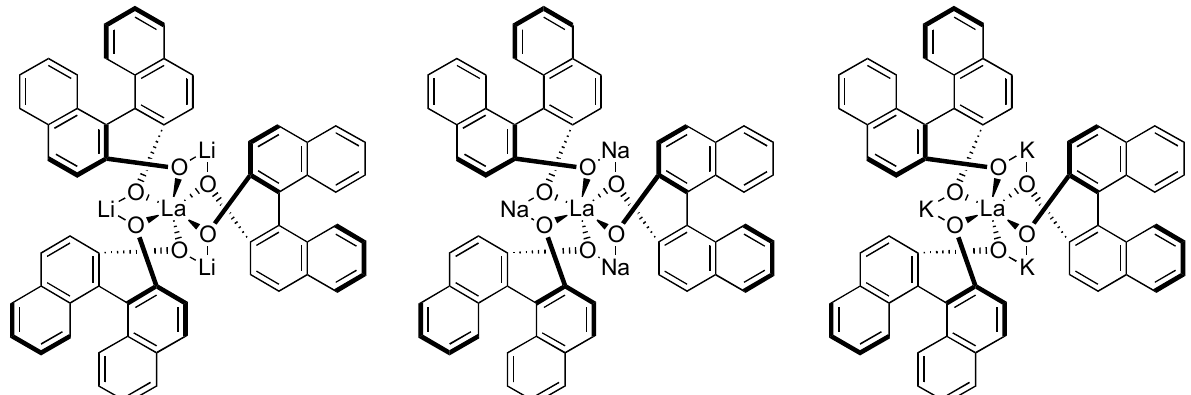
Figure 1. Structures of ( S )-RE-M LLB 1a , LSB 1b , and LPB 1c .